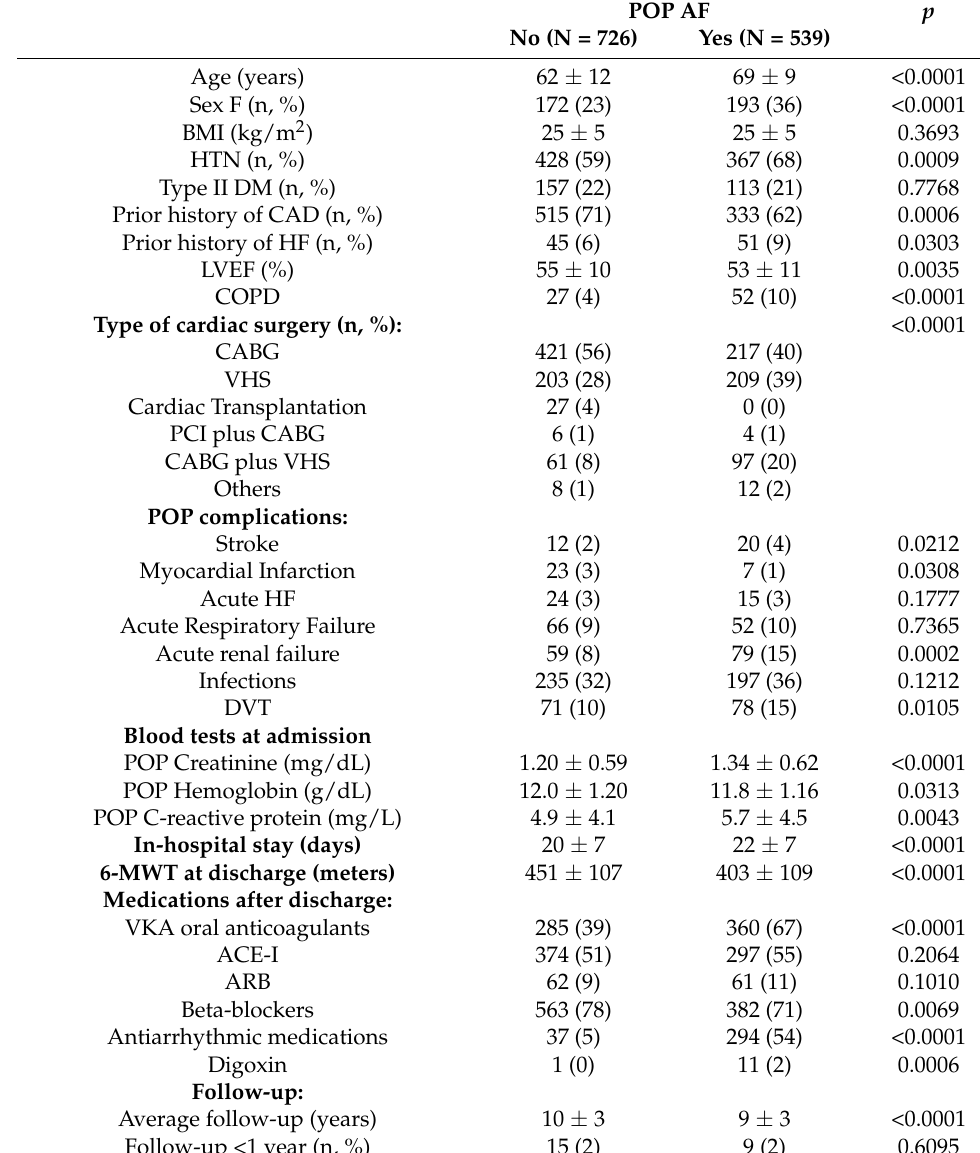
Table 2. Demographic and clinical features of POP AF patients compared with patients without AF before and after